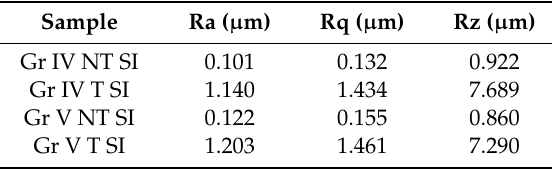
Table 5. Roughness parameters of the samples treated with TiO 2 film (GR IV: Titanium grade IV; GR V: Titanium grade V; T: SLA treated; NT: SLA non-treated; SI: treated with TiO 2